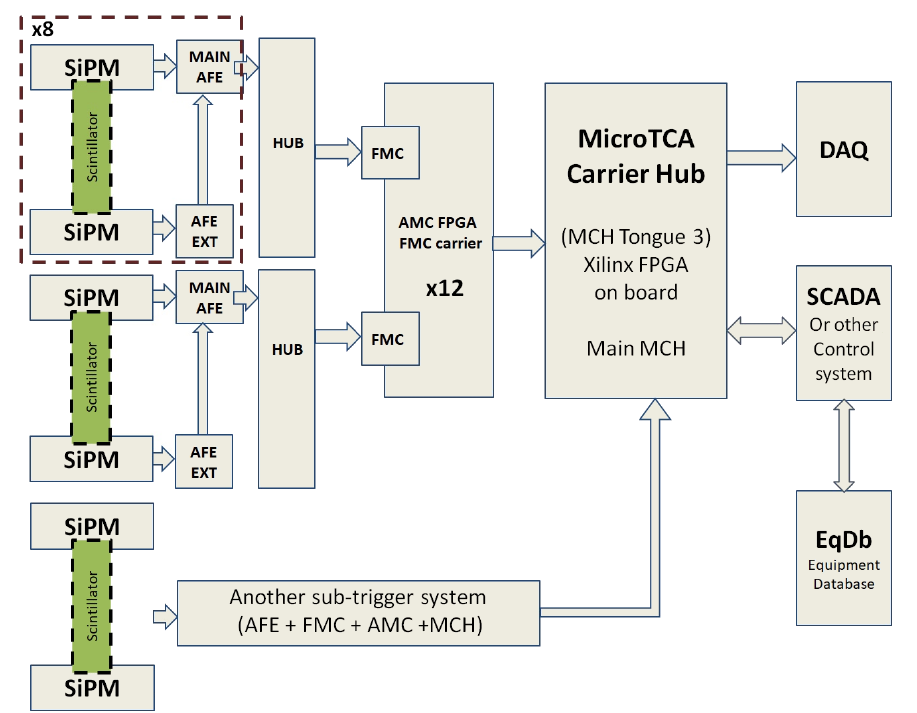
Figure 4. Block scheme of the whole MCORD electronic